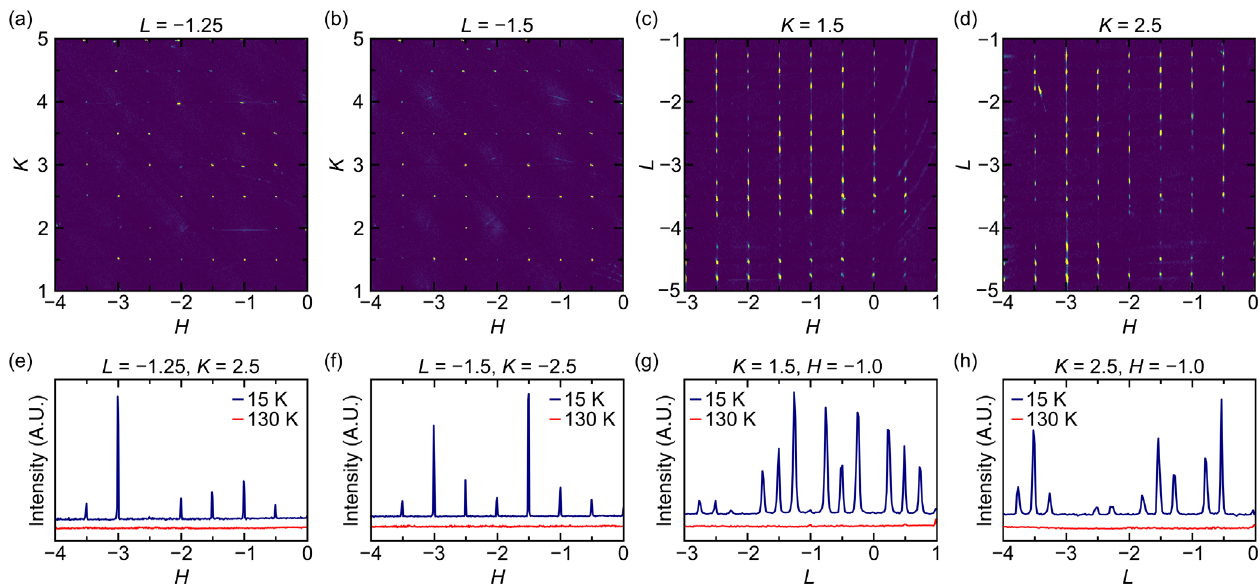
FIG. 2. (a) – (d) Two-dimensional slices through reciprocal space on half-integer Bragg planes at 15 K, highlighting superlattice peaks in CsV 3 Sb 5 . (e) – (h) Line cuts through the 2D data, highlighting the periodicity of the superlattice peaks. Cuts performed at the base temperature of 15 K (blue) contrast data collected at 130 K (red), confirming that the superlattice peaks emerge simultaneous the charge density wave order at T (cid:2) ∼ 94 K. Our data indicate that the superlattice in CsV 3 Sb 5 is described by a wave vector of (0.5, 0.5,